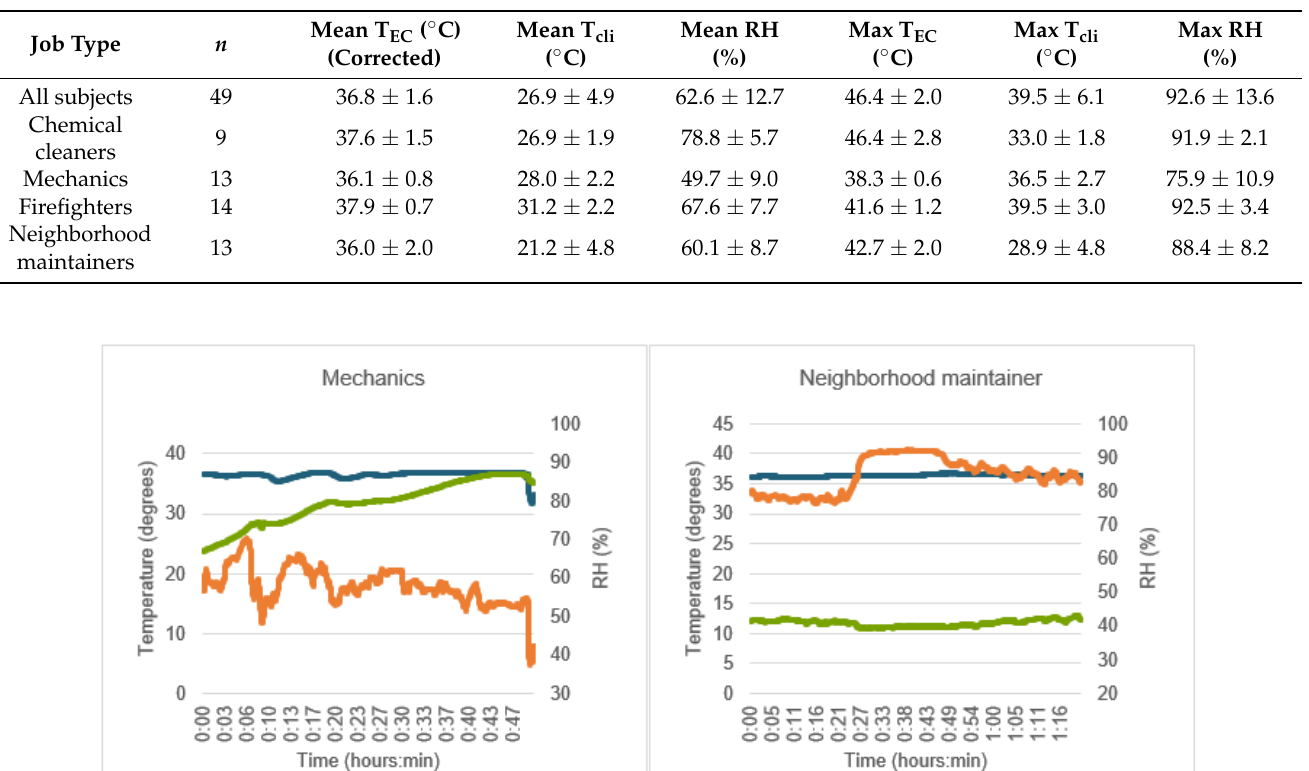
Table 4. Ear canal temperature, micro-climate temperature and relative humidity of all subjects and per job measured. Mean and max ear canal temperature (T EC ) ( ◦ C), nearby micro-climate temperature (T cli ) ( ◦ C) and relative humidity (RH) (%) of all subjects and per job measured with Cosinuss ◦ and ambient conditions chest box.